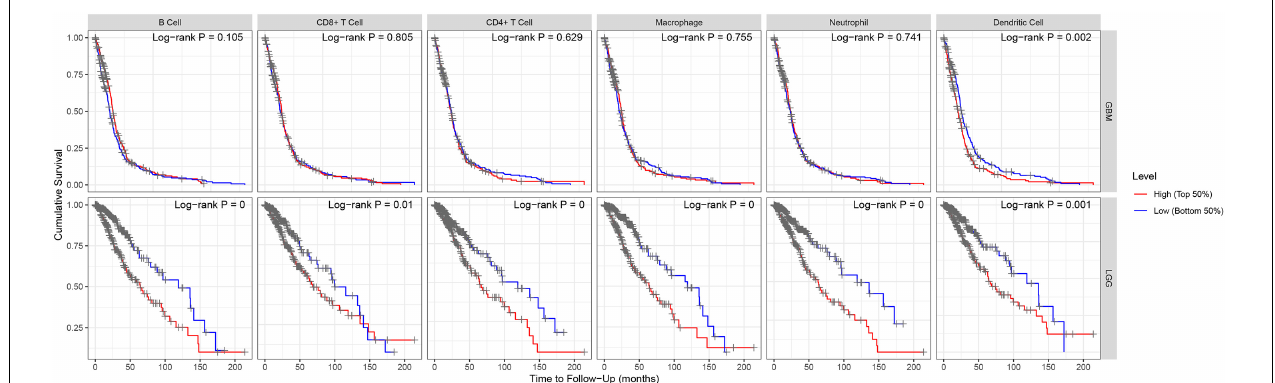
FIGURE 5 | Kaplan–Meier plots of immune infiltration level in GBM and